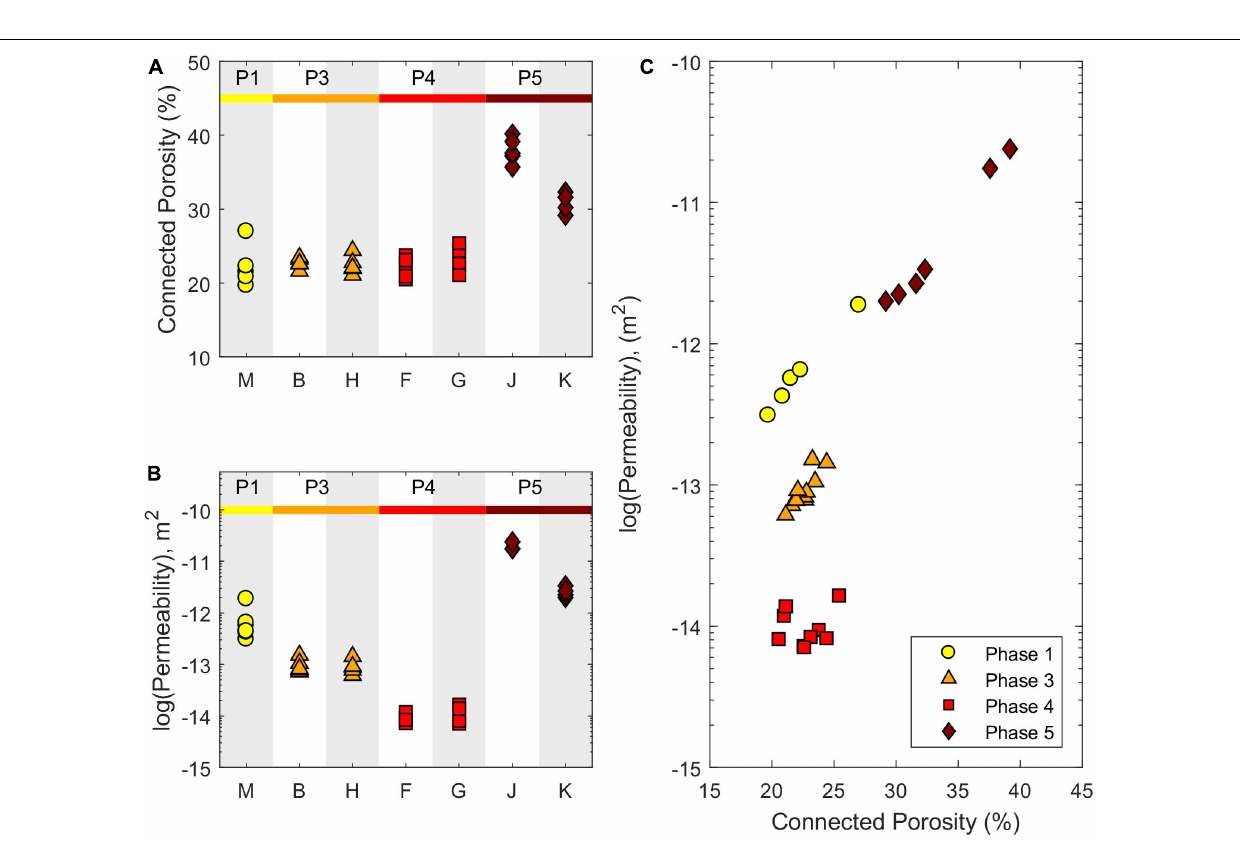
Frontiers in Earth Science |